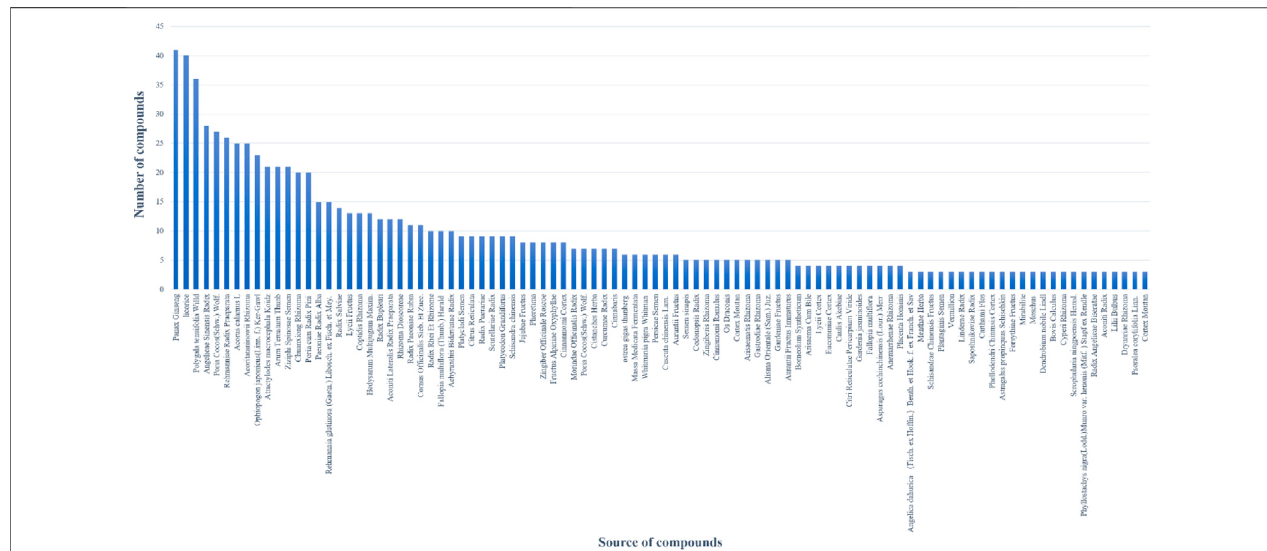
FIGURE 4 | The number of potential active chemical constituents from different Chinese medicinal herbs.